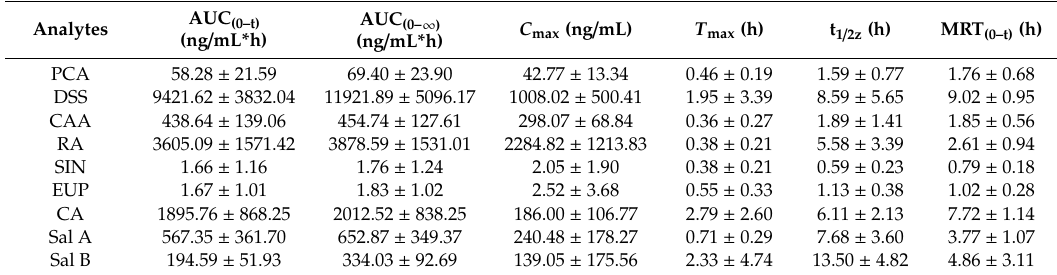
Table 5. Pharmacokinetic parameters of the analytes in rats after oral administration of the OS extract at 10 g / kg ( n = 6, mean ±